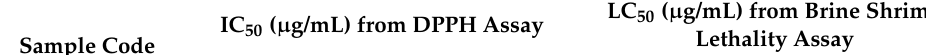
Table 1. Antioxidant potentials and cytotoxic effects with IC 50 (obtained from DPPH assay) and LC 50 (obtained from brine shrimp lethality assay) values of MEB, MEF, and different solvent fractions of W. coccinea